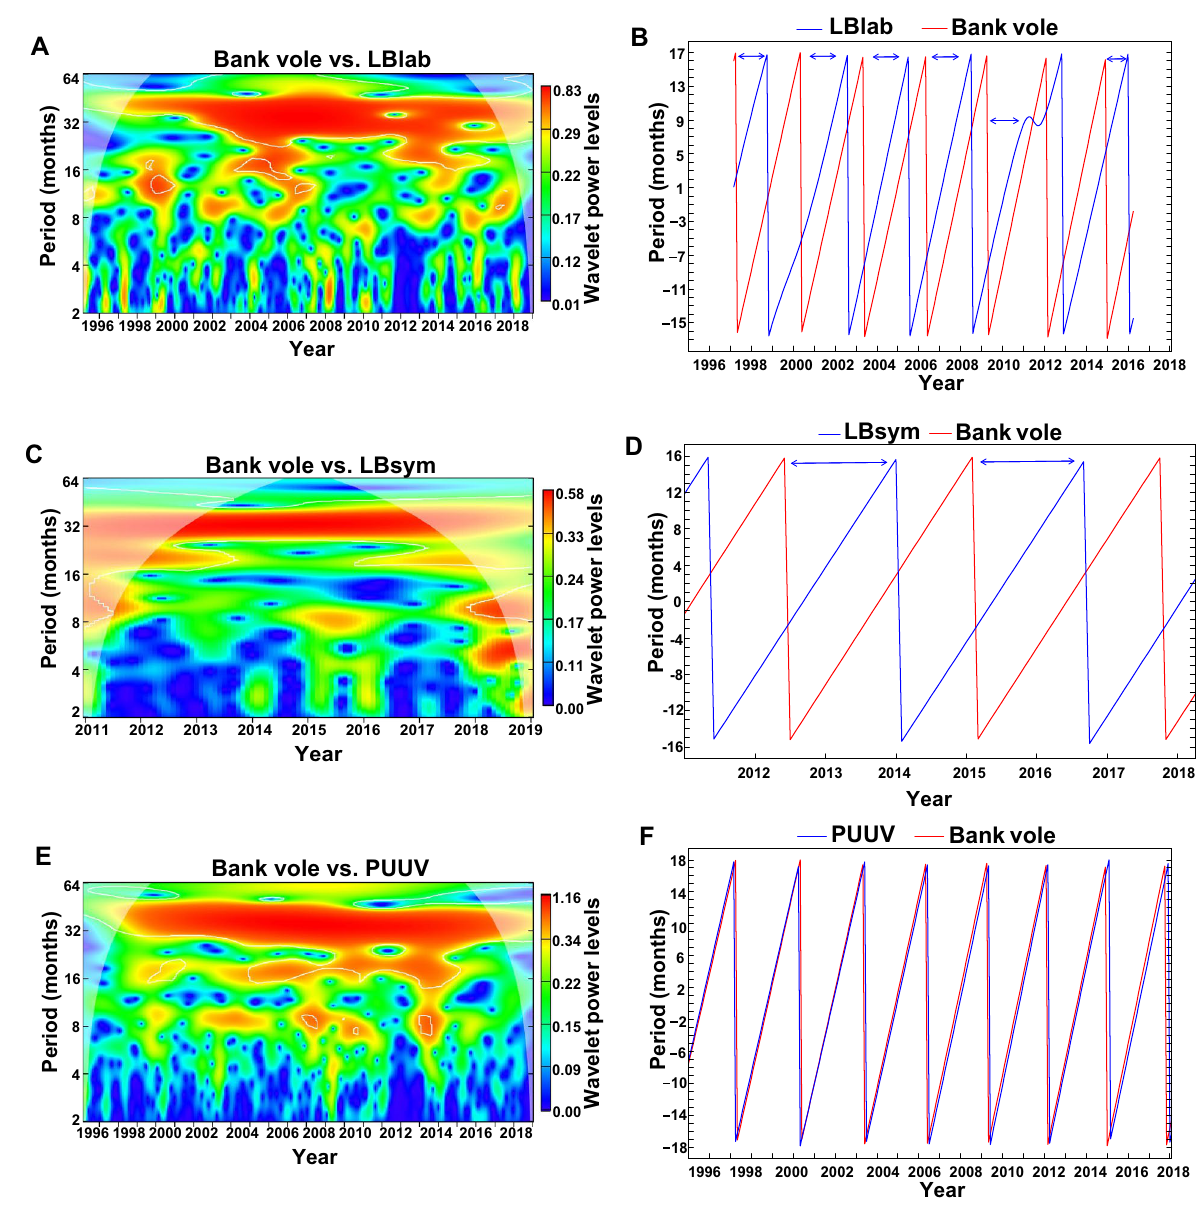
Figure 1. Cross-wavelet power spectra and phase-difference between human infection incidence (LB laboratory, LB symptoms, PUUV) and bank vole abundance. ( A ) Cross-wavelet power between bank vole abundance and LB laboratory incidence. ( B ) Phase-difference plot for LB laboratory incidence (blue line) and bank vole abundance (red line) for the periodicity with a wavelength of 36 months. ( C ) Cross-wavelet power between bank vole abundance and LB symptoms incidence. ( D ) Phase-difference plot for LB symptoms incidence (blue line) and bank vole abundance (red line) for the periodicity with a wavelength of 34 months. ( E ) Cross-wavelet power between bank vole abundance and PUUV incidence. ( F ) Phase-difference plot for PUUV incidence (blue line) and bank vole abundance (red line) for the periodicity with a wavelength of 36 months. In ( A , C , E ) the coherence power is presented by the color gradient from low values (blue) to high values (red). Light color at edges indicates areas influenced by edge effects. Blue arrows in panels ( B , D ) highlight the time lags with which LB incidence follows bank vole abundance. All the time series are de-seasonalized (see “Methods” for more details). Figure generated using R version 3.5.3 58 software with the ‘WaveletComp’ 57